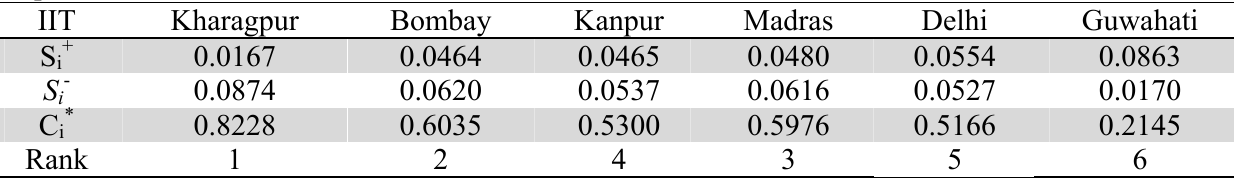
Separation measures and closeness coefficient values